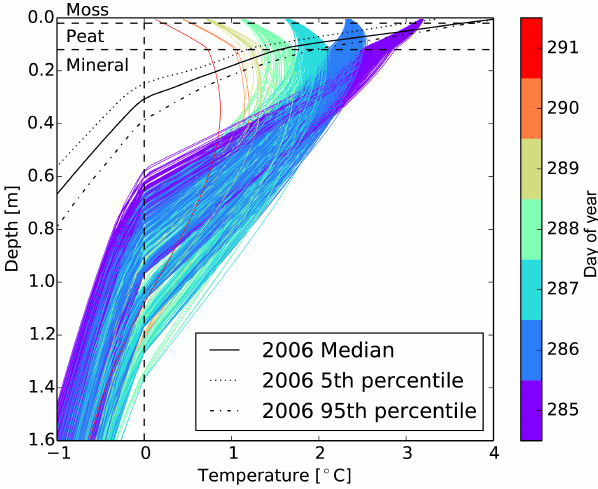
Figure 6. Predictive uncertainty due to soil properties for depth pro- files of temperature for the ensemble when ALT occurs for calendar year 2100. Color indicates the day of the year when ALT occurred for each realization. The 2006 median and 5th and 95th percentiles for the ensemble are plotted for reference. Day of year when ALT occurs for realizations in 2006 is from 246 to 260 (not indicated in the